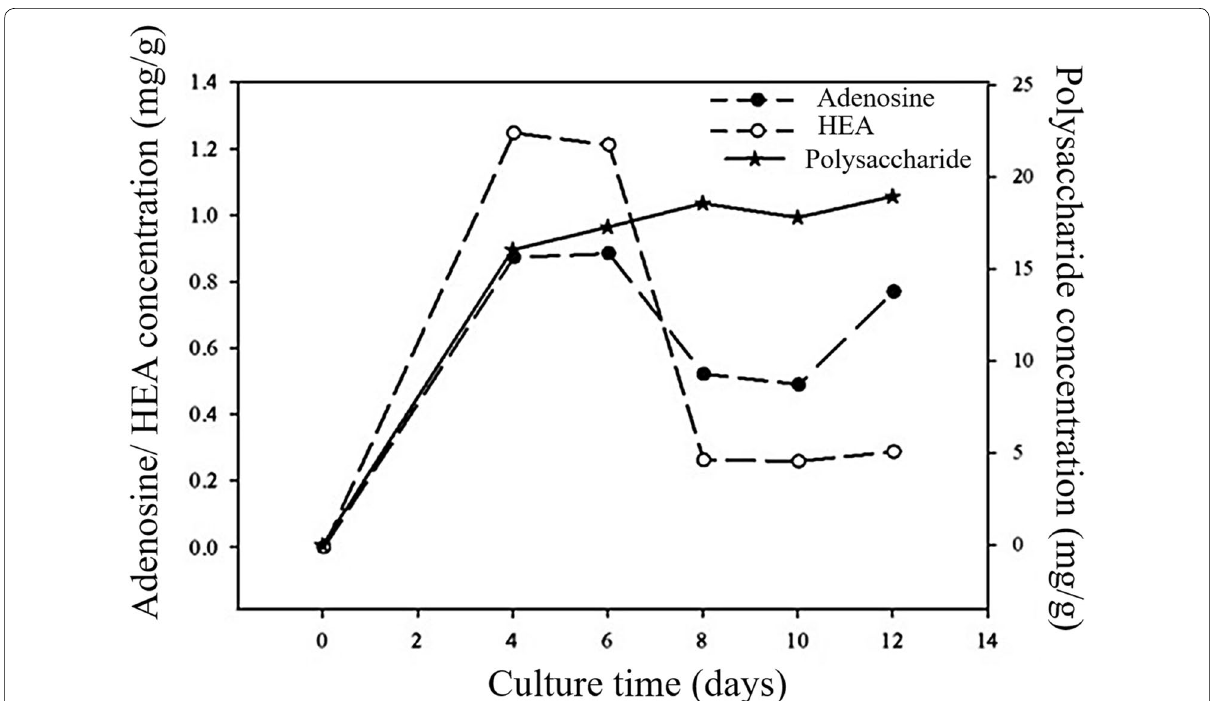
Fig. 3 Time course of adenosine, HEA and polysaccharide contents under pilot‑up fermentation of C. cicadae NTTU 868